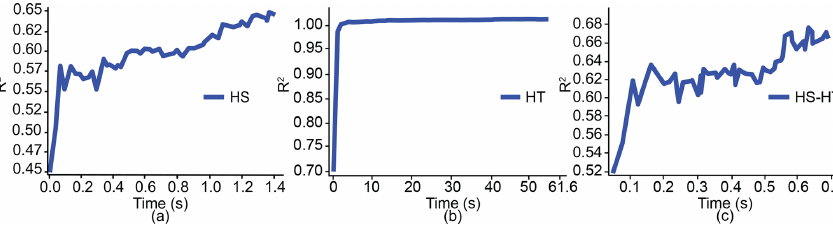
Figure 4. Comparison of the training time for the XGBoost models using hyperparameter selection (HS), hyperparameter tuning (HT), and both of them (HS–HT), as proposed by the framework with respect to their performance measured by R 2 over 8000